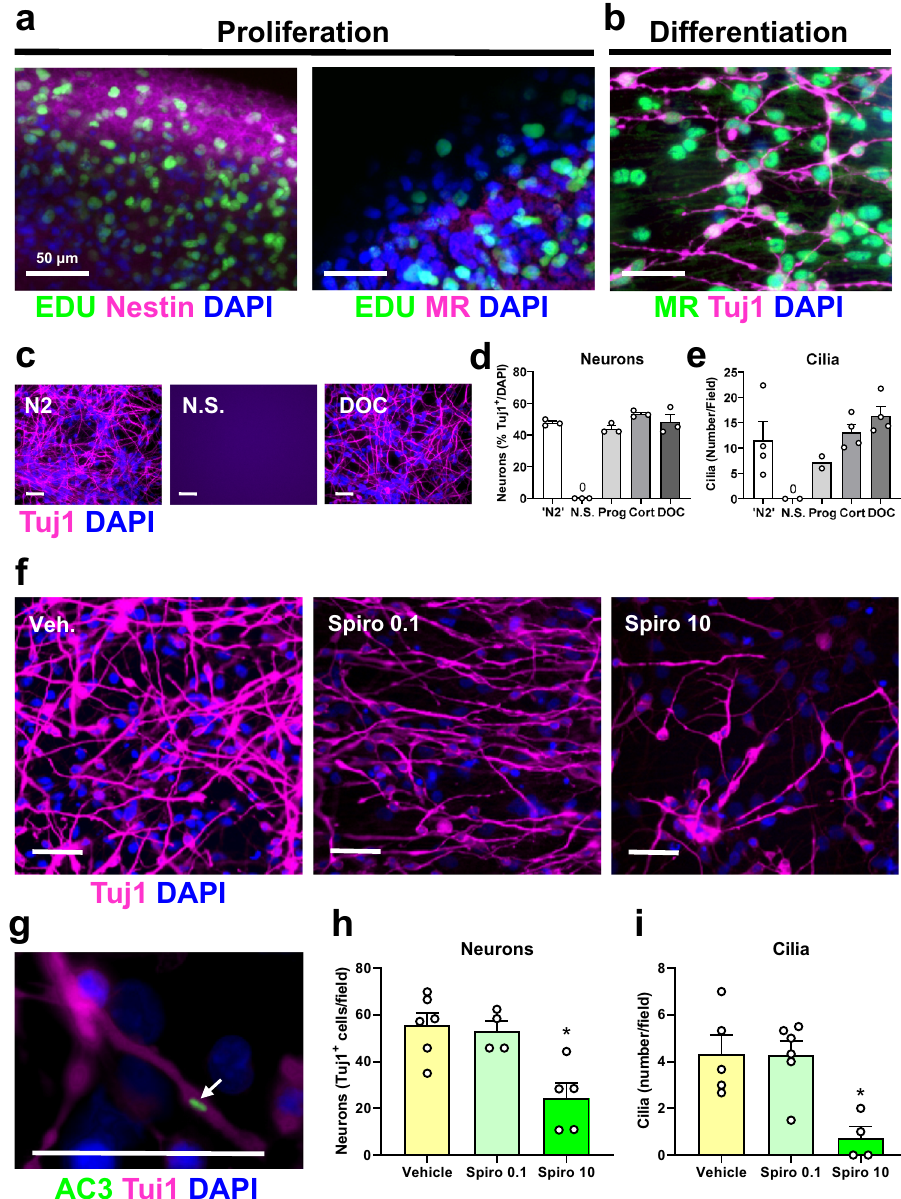
Fig. 10 MR-mediated control of differentiation of and ciliogenesis in human foetal neuronal progenitor cells (hfNPCs). Neurospheres were prepared from human foetal cortex tissue and immuno-stained during proliferation ( a ) and following differentiation ( b ). The white bar in the various panels indicates 50 µ m. a Positive staining for the proliferation marker ethynyl deoxyuridine (EDU (lime green)) and the stem cell marker Nestin con fi rm the proliferative state of the cells whilst MR staining is absent. b Following initiation of differentiation, neuron-speci fi c class III beta-tubulin (Tuj1 (magenta)) identi fi es differentiated young neurons which abundantly express nuclear MRs (lime green). Immuno fl uorescent images are representative of 3 independent experiments. c – e Tuj1-speci fi c staining (magenta) con fi rms that hfNPCs require the presence of progesterone (Prog), corticosterone (Cort) or deoxycorticosterone (DOC) for both neuronal differentiation and cilia expression. Absence of any steroid (N.S.) completely abolishes these processes (Tuj1 (Neurons): mean ± SEM, n = 3 independent replicates for all experimental groups; Oneway ANOVA: F(4,10) = 82.98, p < 0.0001; Cilia: mean ± SEM, n = 4 independent replicates for ‘ N2 ’ , Cort and DOC; n = 2 independent replicates for N.S. and Prog. Oneway ANOVA: F(4,11) = 4.508, P = 0.0212; post-hoc Dunnett ’ s test was not conducted as N.S. group is zero neurons/cilia and, in case of cilia, the N.S. and Prog groups were n = 2). Images in c are representative of 3 independent experiments. f Representative images (of 6 (Veh.), 4 (Spiro 0.1) and 5 (Spiro 10) independent experiments) indicating that the presence of MR-selective antagonist spironolactone (0.1, 10 μ M) causes a dose-dependent inhibition of neuronal differentiation (Tuj1-speci fi c staining, magenta). g Representative image (of 4 independent experiments) of a cilium (adenylate cyclase 3 (AC3) staining, lime green, indicated by the arrow) on a young Tuj1-positive neuron. h , i Quanti fi cation of neurons and cilia con fi rms inhibition by spironolactone: Tuj1 (Neurons), mean ± SEM, n = 6 independent replicates (Vehicle), 4 independent replicates (Spiro 0.1), and 5 independent replicates (Spiro 10)): Oneway ANOVA: F(2,12) = 9.637, p = 0.0032, post- hoc Dunnett ’ s test (two-sided): * p = 0.0029; Cilia, mean ± SEM, n = 5 independent replicates (Vehicle), 6 independent replicates (Spiro 0.1), and 4 independent replicates (Spiro 10): Oneway ANOVA: F(2,12) = 8.296, p = 0.0055, post-hoc Dunnett ’ s test (two-sided): * p = 0.0071). Source data are provided in the Source Data